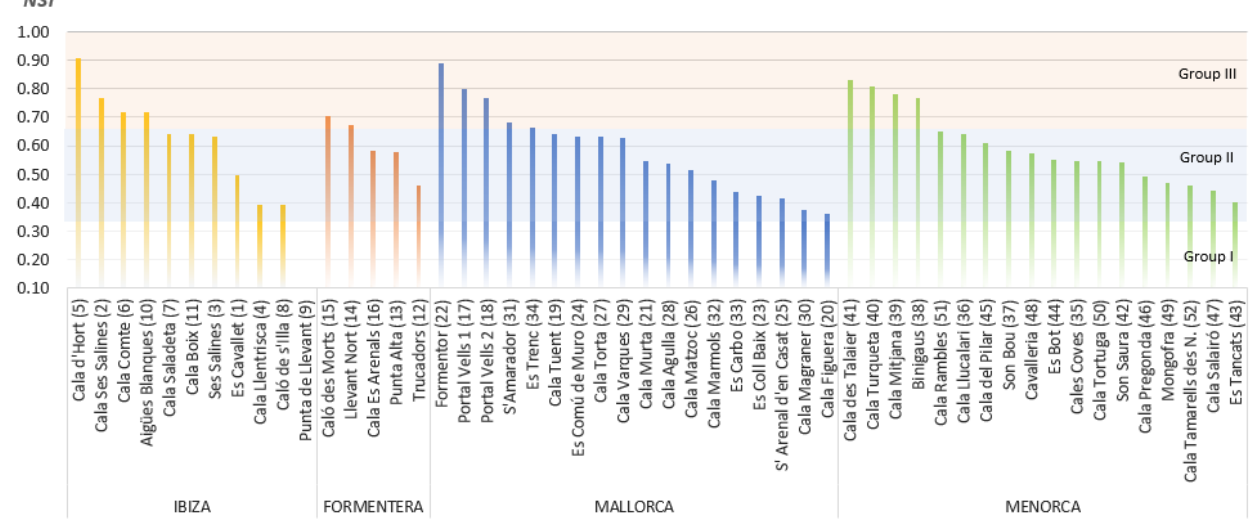
Figure 11. NSI value obtained at the 52 sites investigated in the Balearic Islands (CSSI